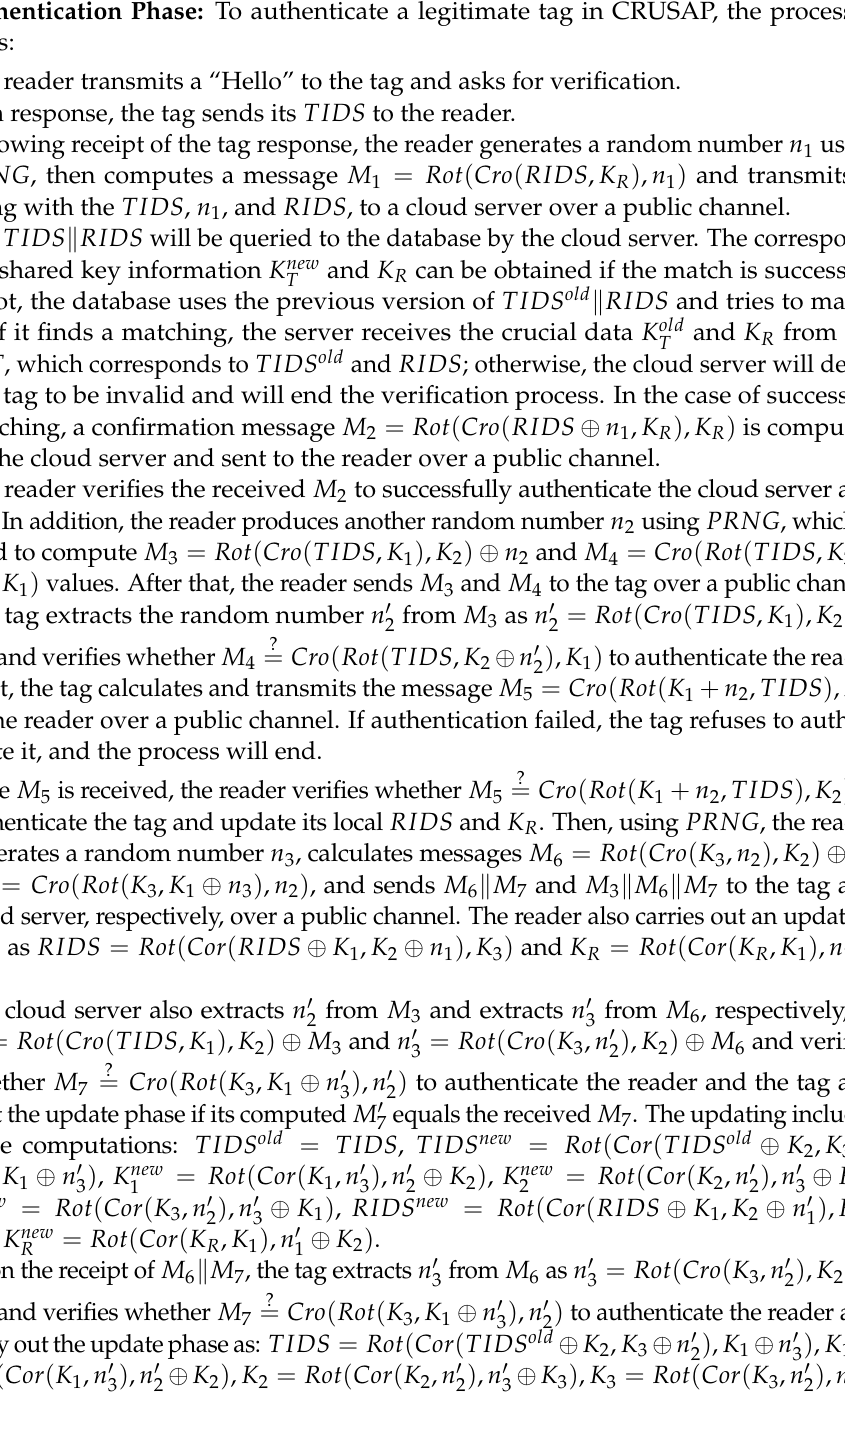
table IDT , which uses TIDS (cid:107) RIDS as an index to find the related K T and K R necessary for verification. The tag also stores TIDS and K T ( K 1 , K 2 , K 3 ) . Moreover, the reader stores RIDS and K R . It is worth noting that the mapping table IDT will keep the index TIDS old (cid:107) RIDS and its content during the previous round of